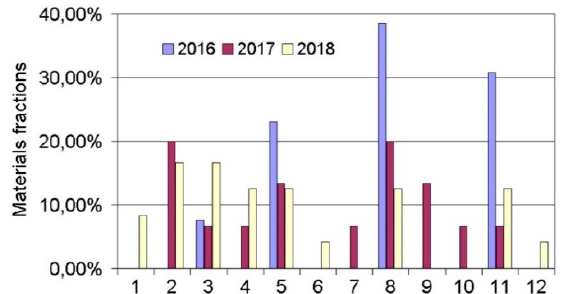
Figure 3. Frequency of use of materials in research articles containing expert knowledge of new technologies and involving investigations into features of single tracks in laser processing (here, 1—Fe alloys, 2—Ti alloys, 3—CrNi alloys, 4—Ceramics, 5—Al alloys, 6—High-speed steel, 7—Bronze, 8—Stainless steel, 9—Special alloys, 10—Tool steel, 11—Super-alloys, 12—others).